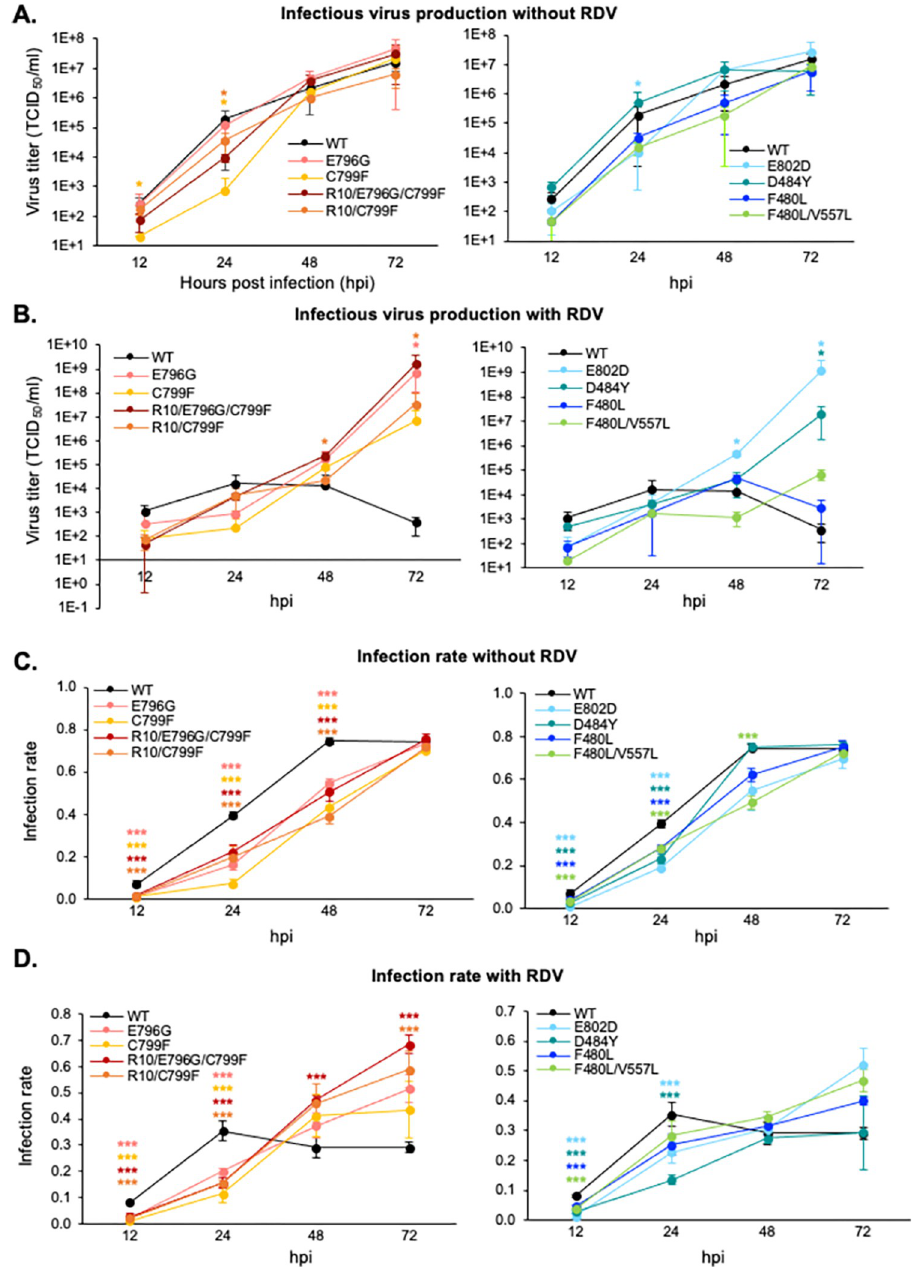
Fig 2. Infection kinetics of recombinant SARS-CoV-2 with NSP12 mutations. (A and B) Infectious virus production in the absence (A) and presence (B) of RDV. Supernatants of virus-infected cells were collected from 12– 96 hpi and virus titers were determined by titration. Statistical significances were determined by Kruskal–Wallis test with the two stage linear step-up procedure of Benjamini, Kreiger and Yekutieli. Significant differences compared with WT virus are indicated by an asterisk ( * p < 0 . 05 ). (C and D) Infection rate in the absence (C) and presence (D) of RDV. Virus-infected cells were fixed and stained with antibodies for SARS-CoV-2 and cell nuclei. Infection rates were calculated by dividing the numbers of virus-positive cells by the numbers of nuclei. Statistical significances were determined by one-way ANOVA with Dunnett’s test. Significant differences compared with WT virus are indicated by asterisks ( *** p < 0 . 001